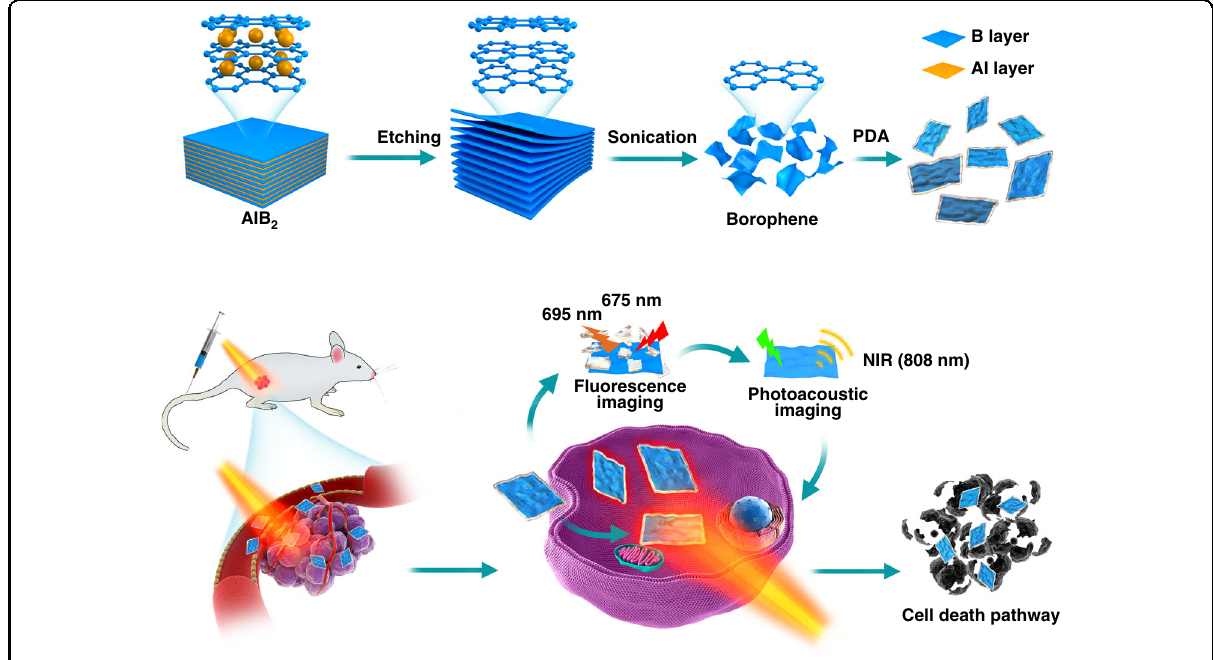
Fig. 1 Schematic illustration. Similar to the fabrication process of MXene, the borophene was obtained through etching its precursor. Then, the modi fi ed borophene was applied in multi-imaging guided photothermal